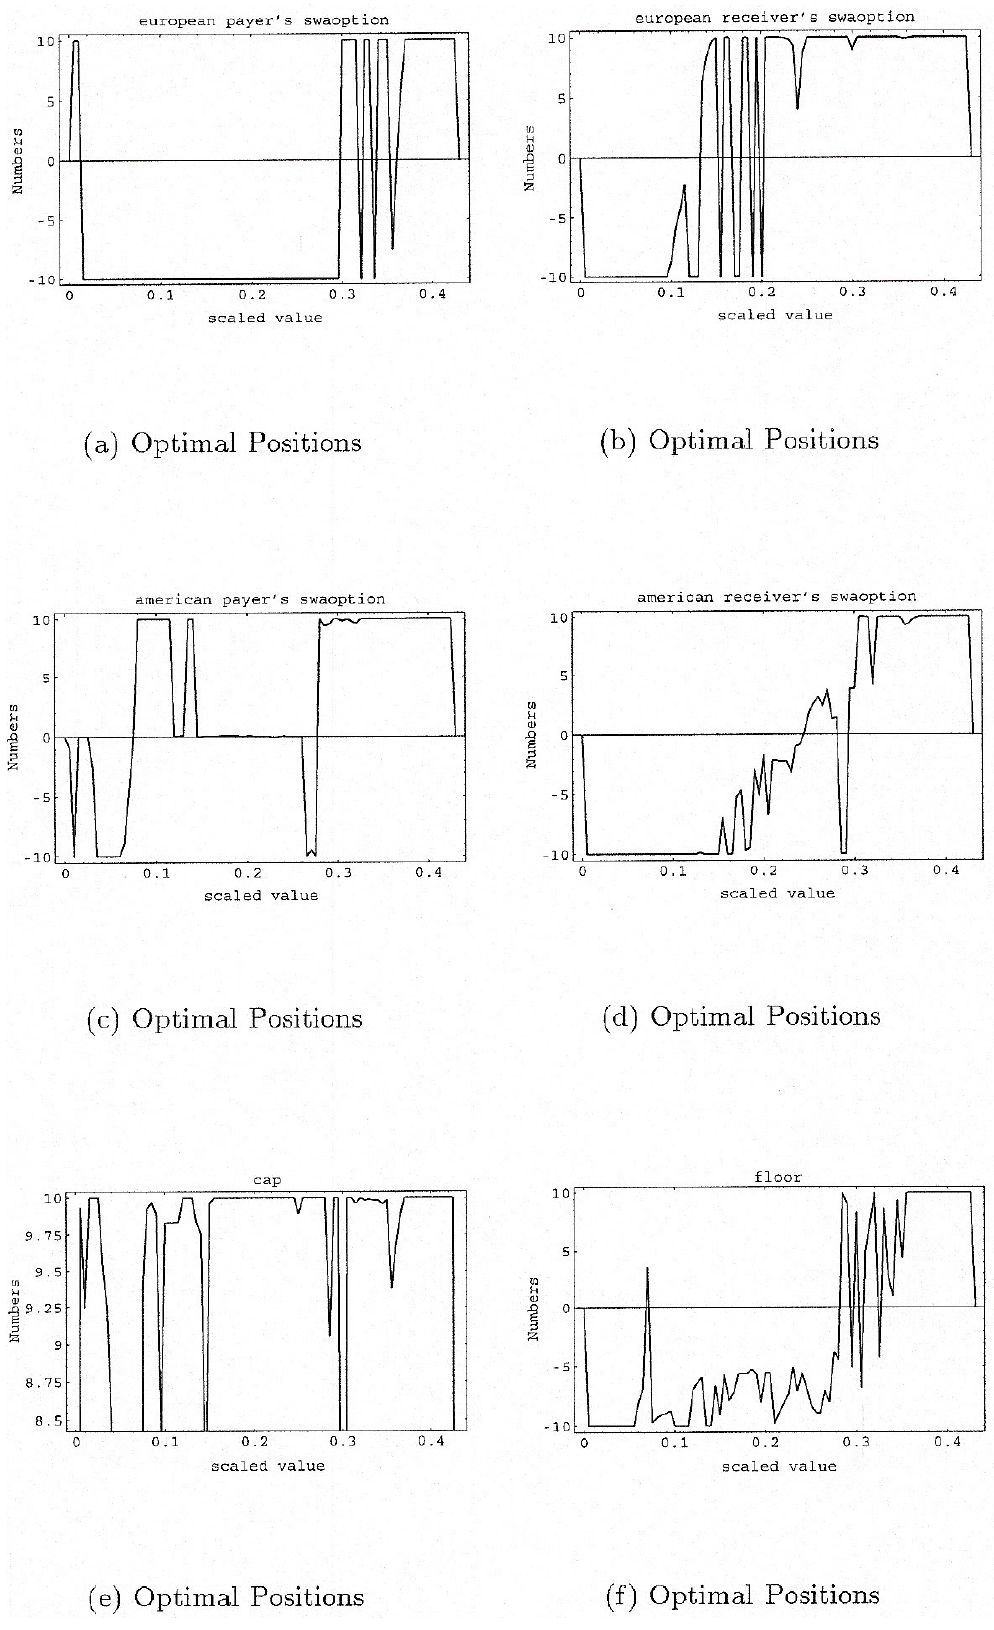
Figure 7. Optimal Positions at time